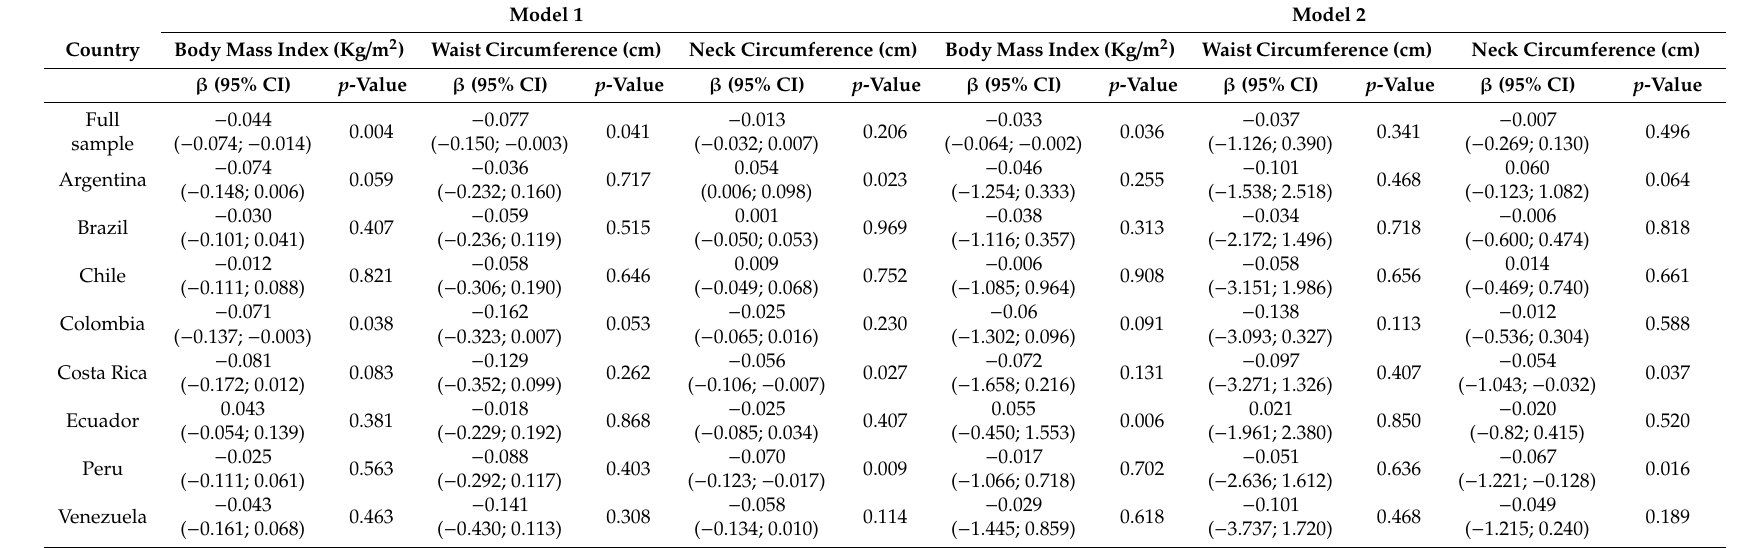
Table 3. Linear regression models for association of active transportation with obesity